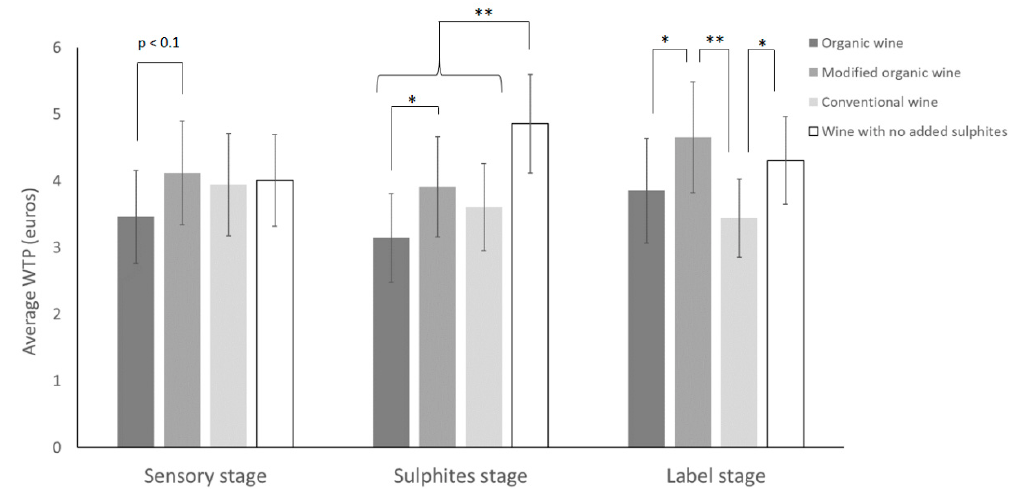
Figure 2. Average WTP (average ± 95% confidence interval) for each wine according to the different stages of the experimental procedure (sensory, sulphites, label). ANOVA, post hoc Fisher (LSD) test, * p -value < 0.05; ** p -value < 0.01.